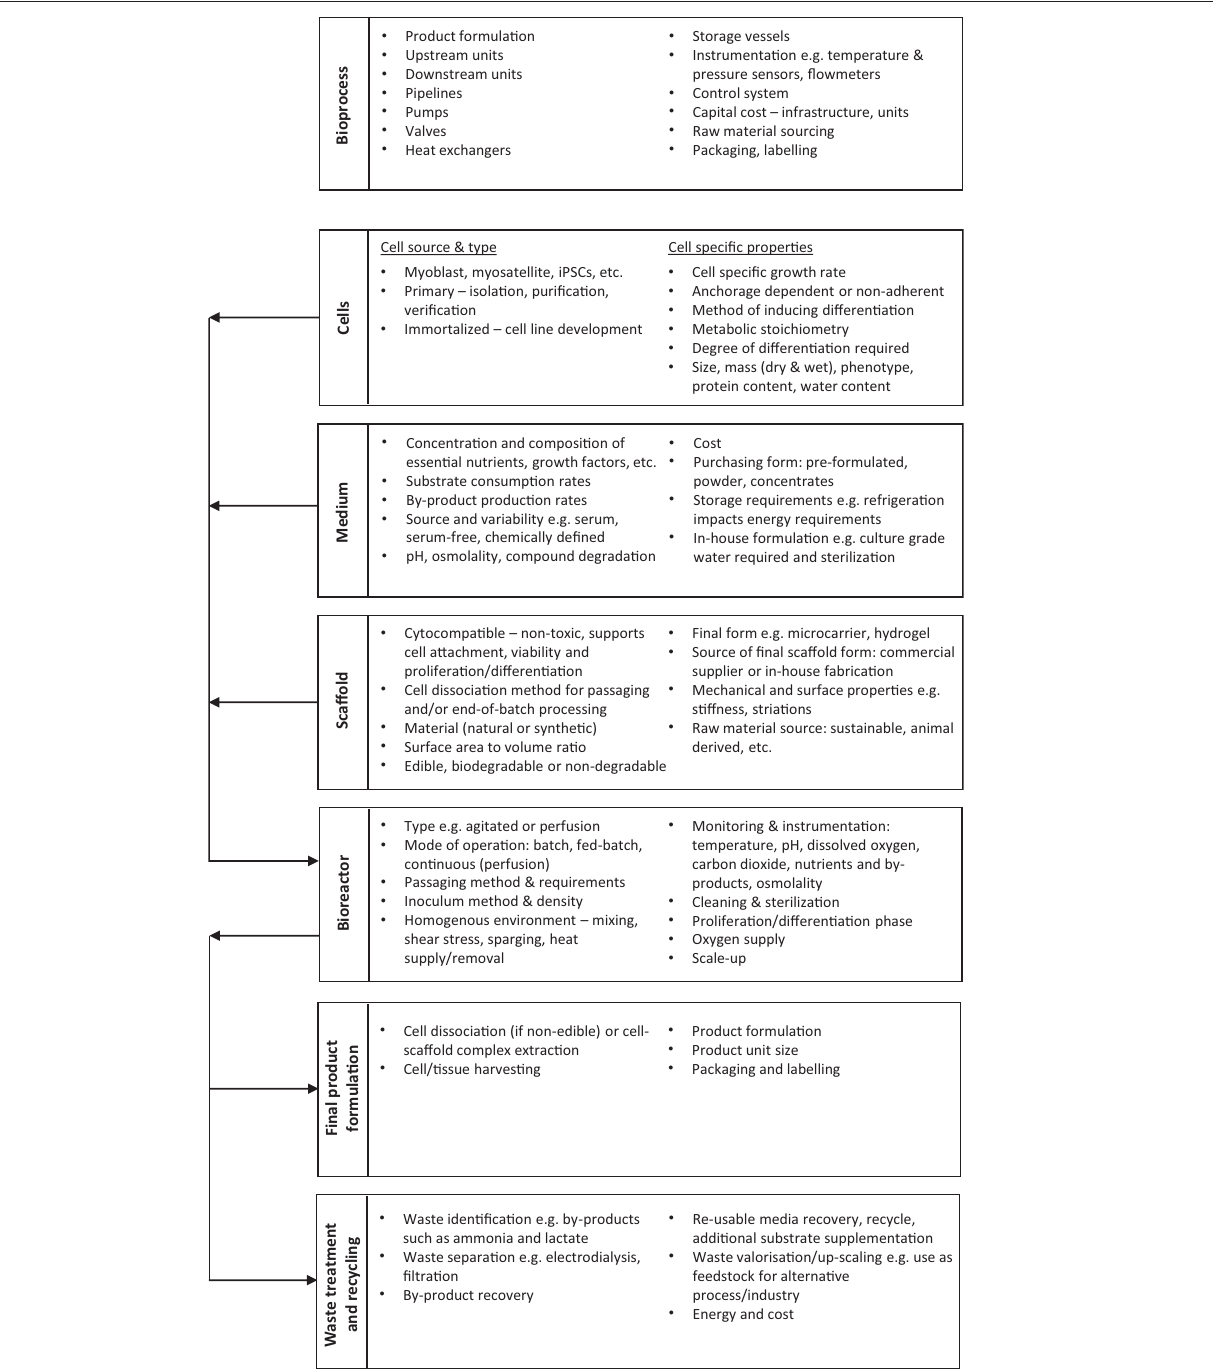
aggregates could also be used (Masters and Stacey, 2007; Beers et al., 2012; Daniszewski et al., 2018). These alternatives may be preferable in serum-free applications as serum is not required to inhibit enzymatic